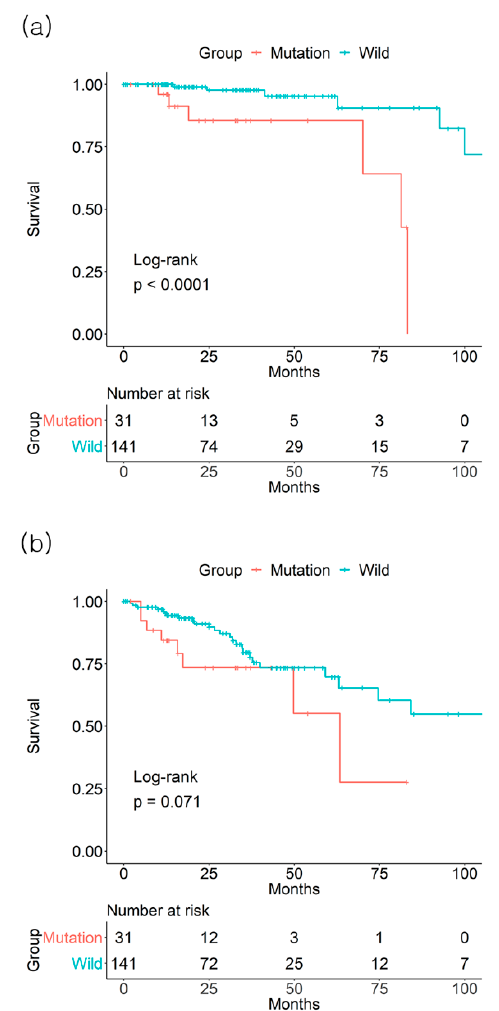
Figure 2. Effect of BRAF mutation on ( a ) 3-year overall survival and ( b ) 3-year disease-free survival from the The Cancer Genome Atlas (TCGA) database of colorectal cancer stage II patients.